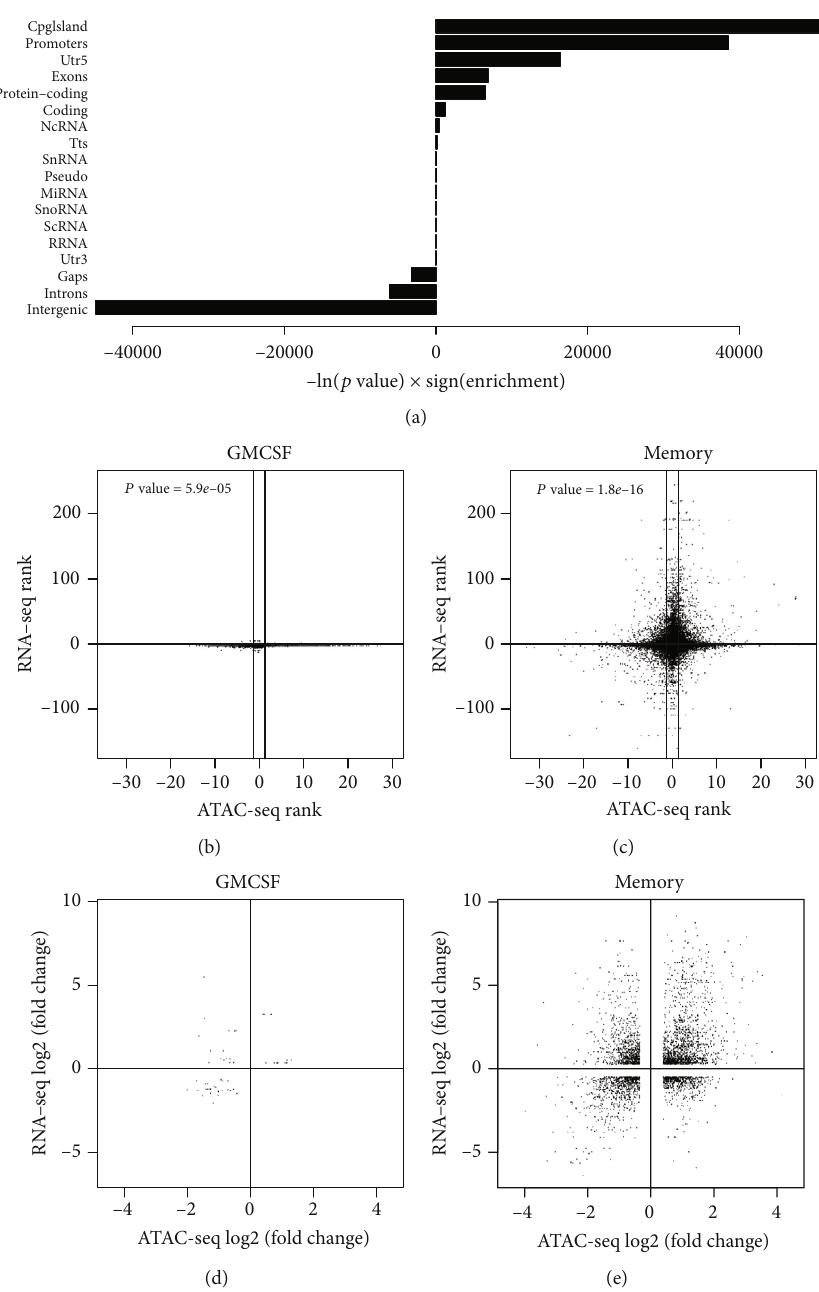
Figure 6: Enrichment of ATAC-seq peaks in regions representing certain genomic features and relationship of ATAC-seq and RNA-seq data. (a) The enrichment of ATAC-seq consensus peaks in di ff erent types of genomic regions is shown with bars representing the enrichment significance × direction of enrichment ð − ln ð P value Þ × sign ð enrichment ÞÞ . (b, c) Genes that were detected on the RNA-seq level and were ð FDR Þ × sign ð log ð foldchange ÞÞ function based on both RNA-seq and also assigned to ATAC-seq peaks were ranked using the – log 10 2 ATAC-seq (using values of the assigned peaks) within a given cell type comparison ((b) GM-CSF+ vs. GM-CSF − ; (c) memory vs. naïve). The ranks of genes using ATAC-seq vs. RNA-seq for ranking are visualized for both cell type comparisons; lines indicate FDR cuto ff 0.05 in the respective comparison. P value represents the probability of observing this or more directional agreement between the two data types by chance, using only genes signi fi cantly di ff erential ( FDR < 0 : 05 ) in both data types. P values were calculated by Fisher ’ s exact test ð foldchange Þ for ranking and visualizing only with Monte Carlo simulation. (d, e) Dot plot representation as in (b, c), but using log 2 (assigned) genes that are signi fi cantly di ff erential in both data